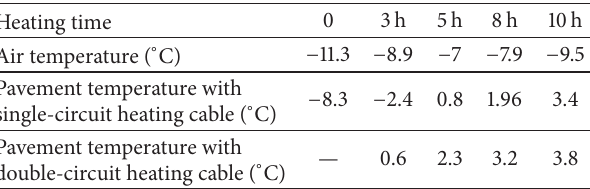
Table 1: Temperature monitored in field